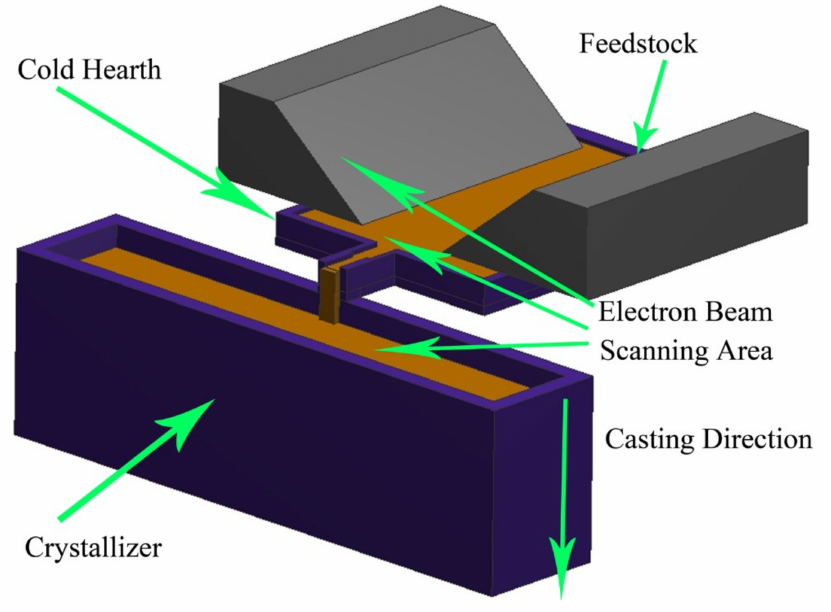
Figure 1. Schematic of electron beam cold hearth melting